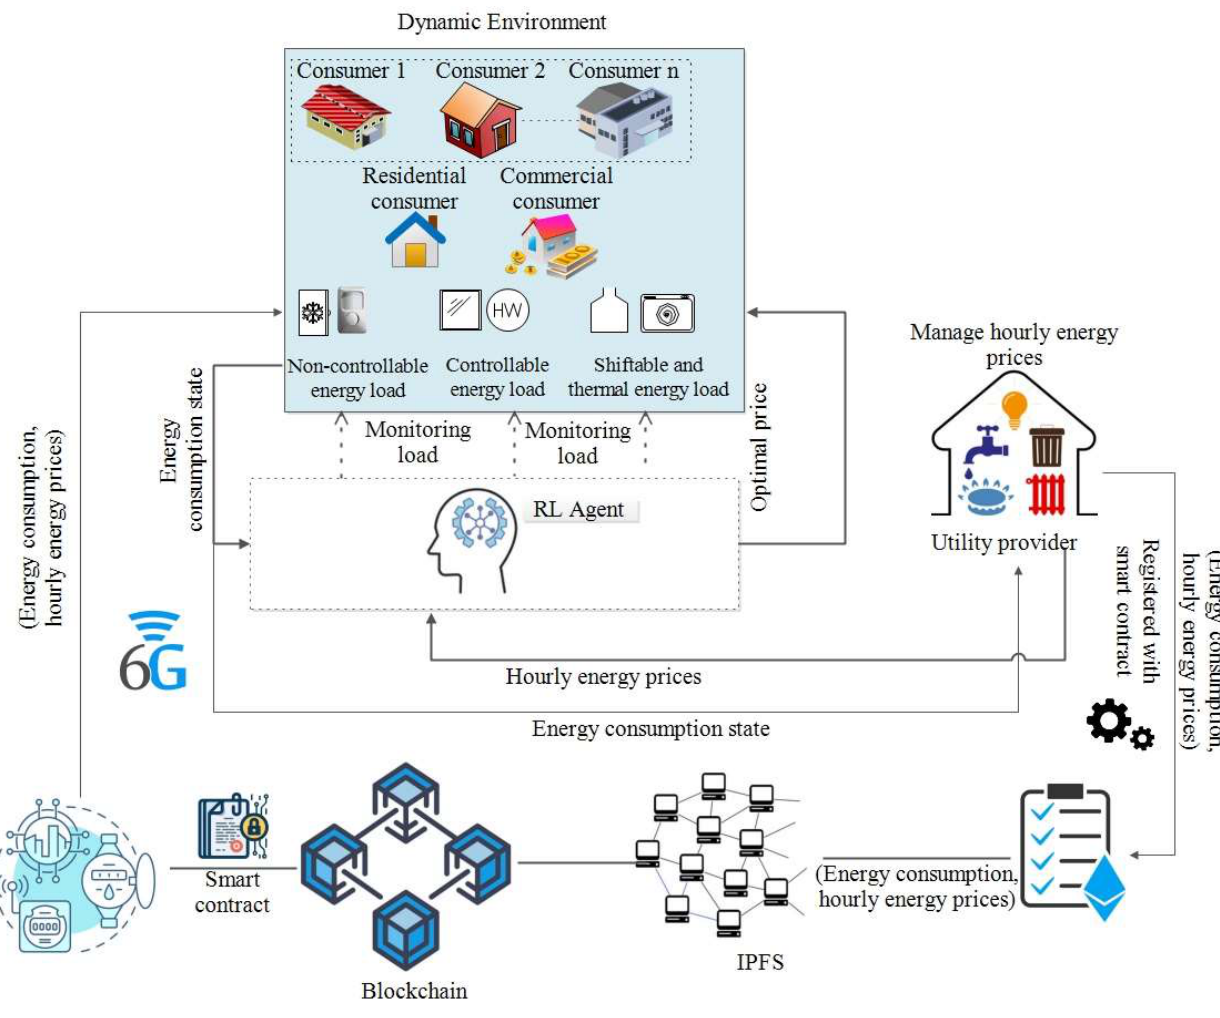
Figure 1. System